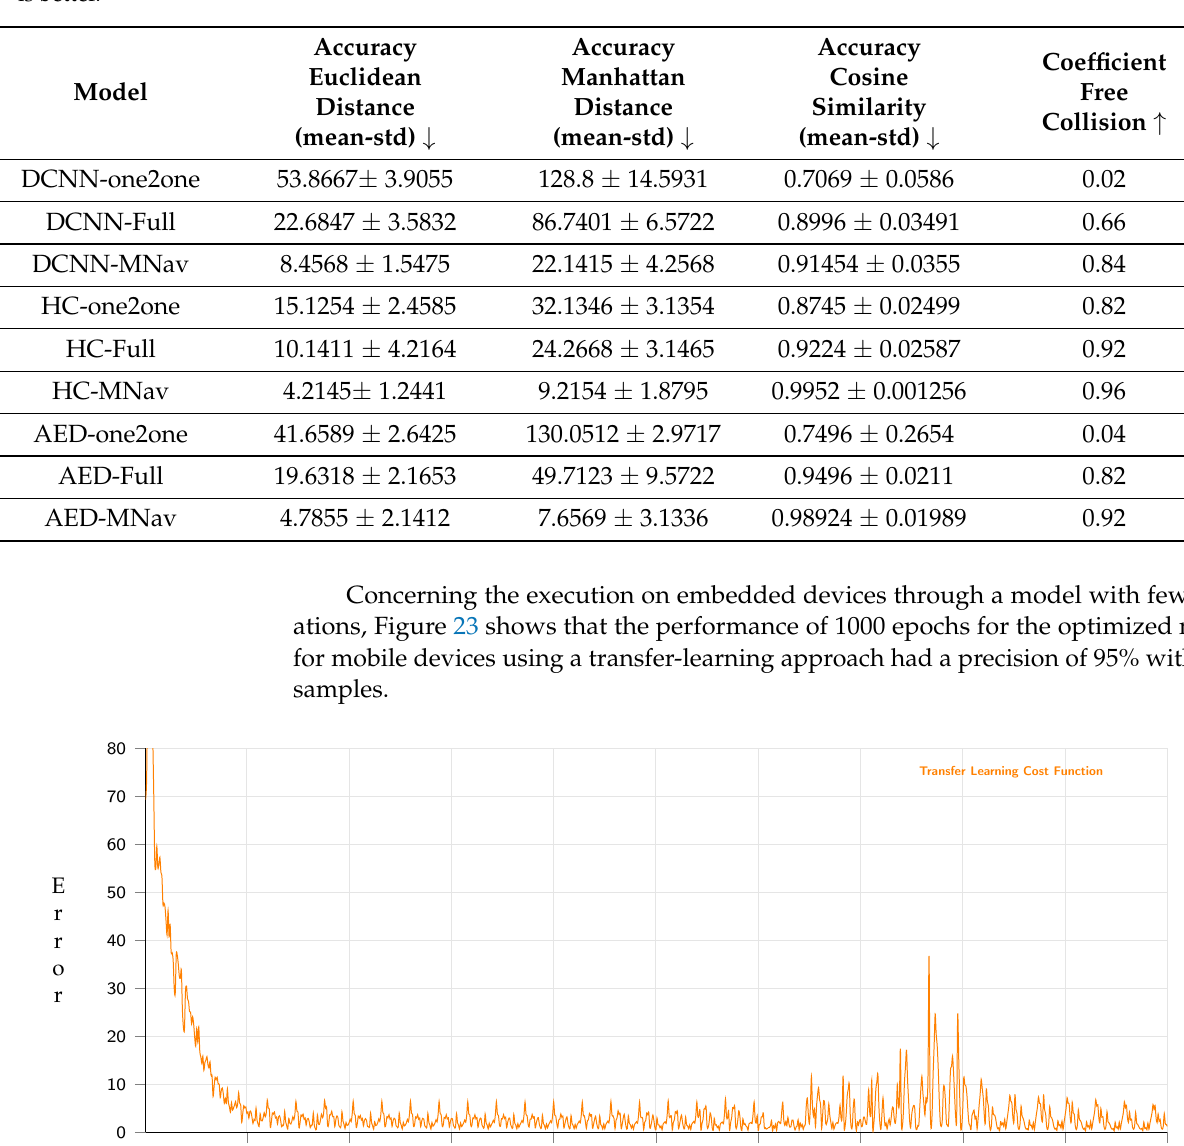
Table 4. Performance of the end-to-end approach and its standard deviation in 50 samples. ↓ , lower is better; ↑ , higher is better.